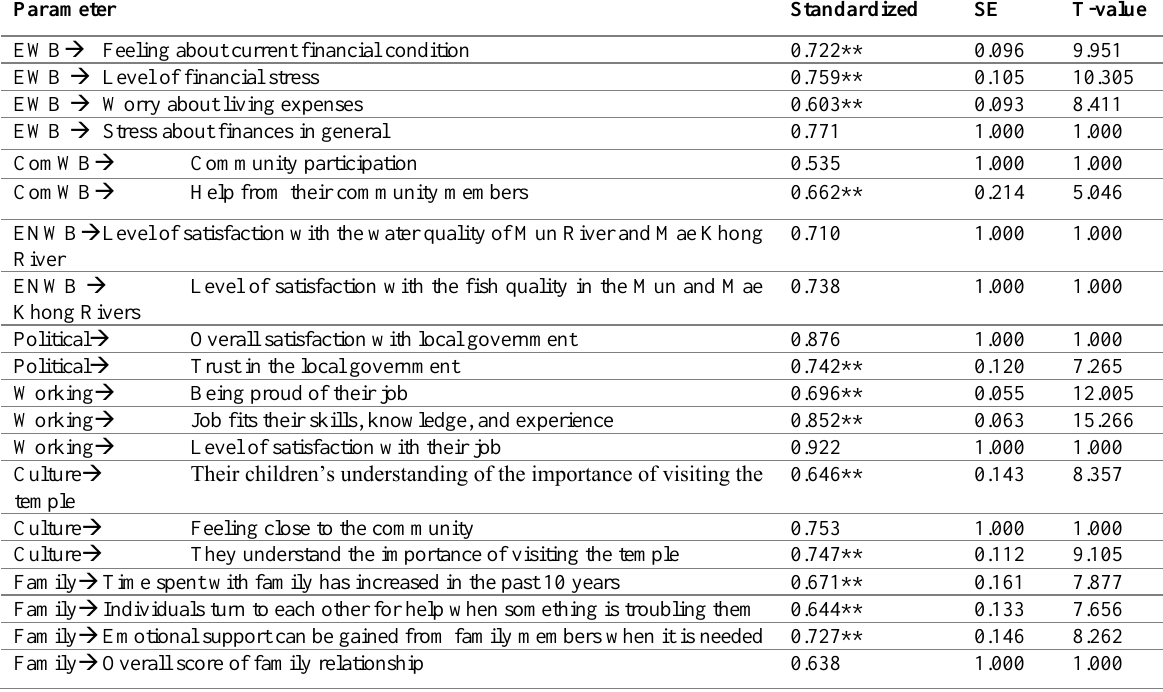
Table 3: Result of Seven Well-Being Dimensions Impacting Overall Well-Being (Chaiyamart et al., 2021) Parameter